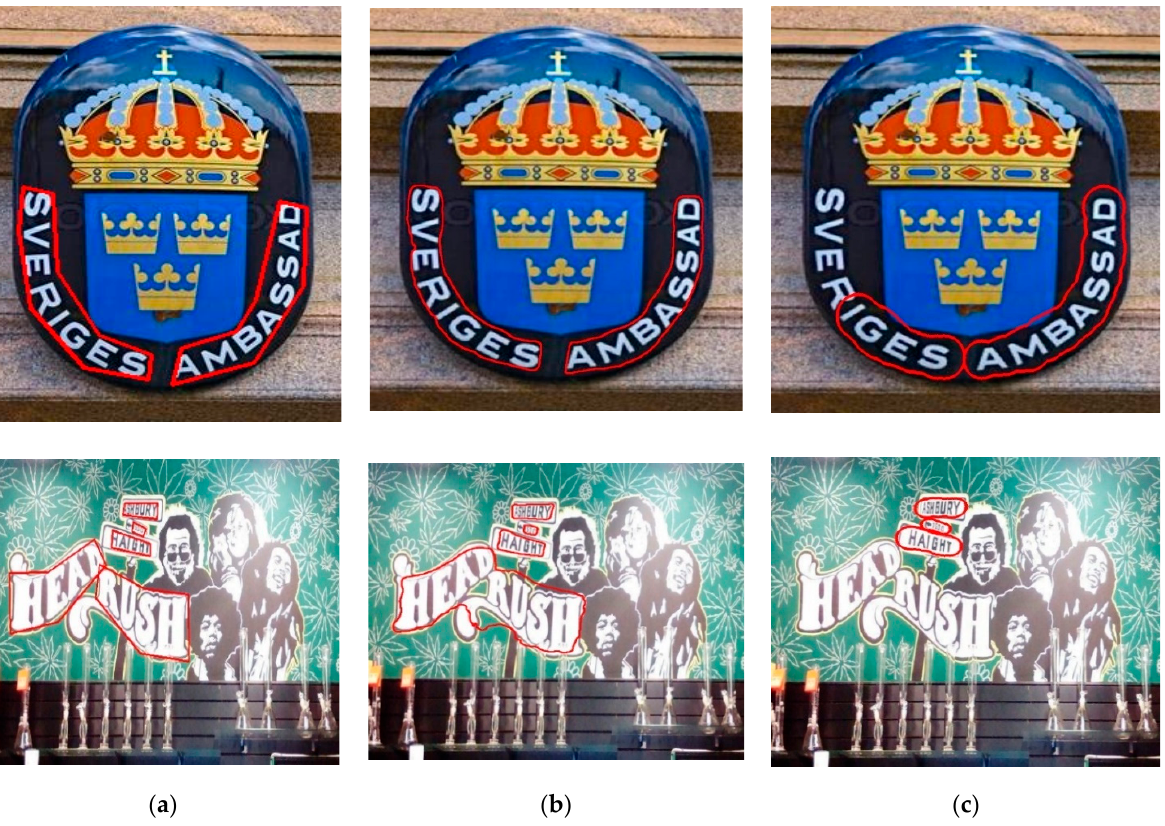
Figure 5. Visualization results on the Total-Text dataset, where ( a ) is the visualization result of ground truth, ( b ) is the result detected by the algorithm in this paper, and ( c ) is the visualization result of the TextSnake model.